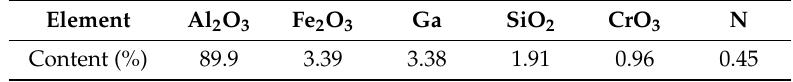
Figure 4. ( a ) X-ray diffraction (XRD) analysis of the GaN waste with Al 2 O 3 peak; ( b ) X-ray diffraction (XRD) analysis of the GaN waste with GaN peak.